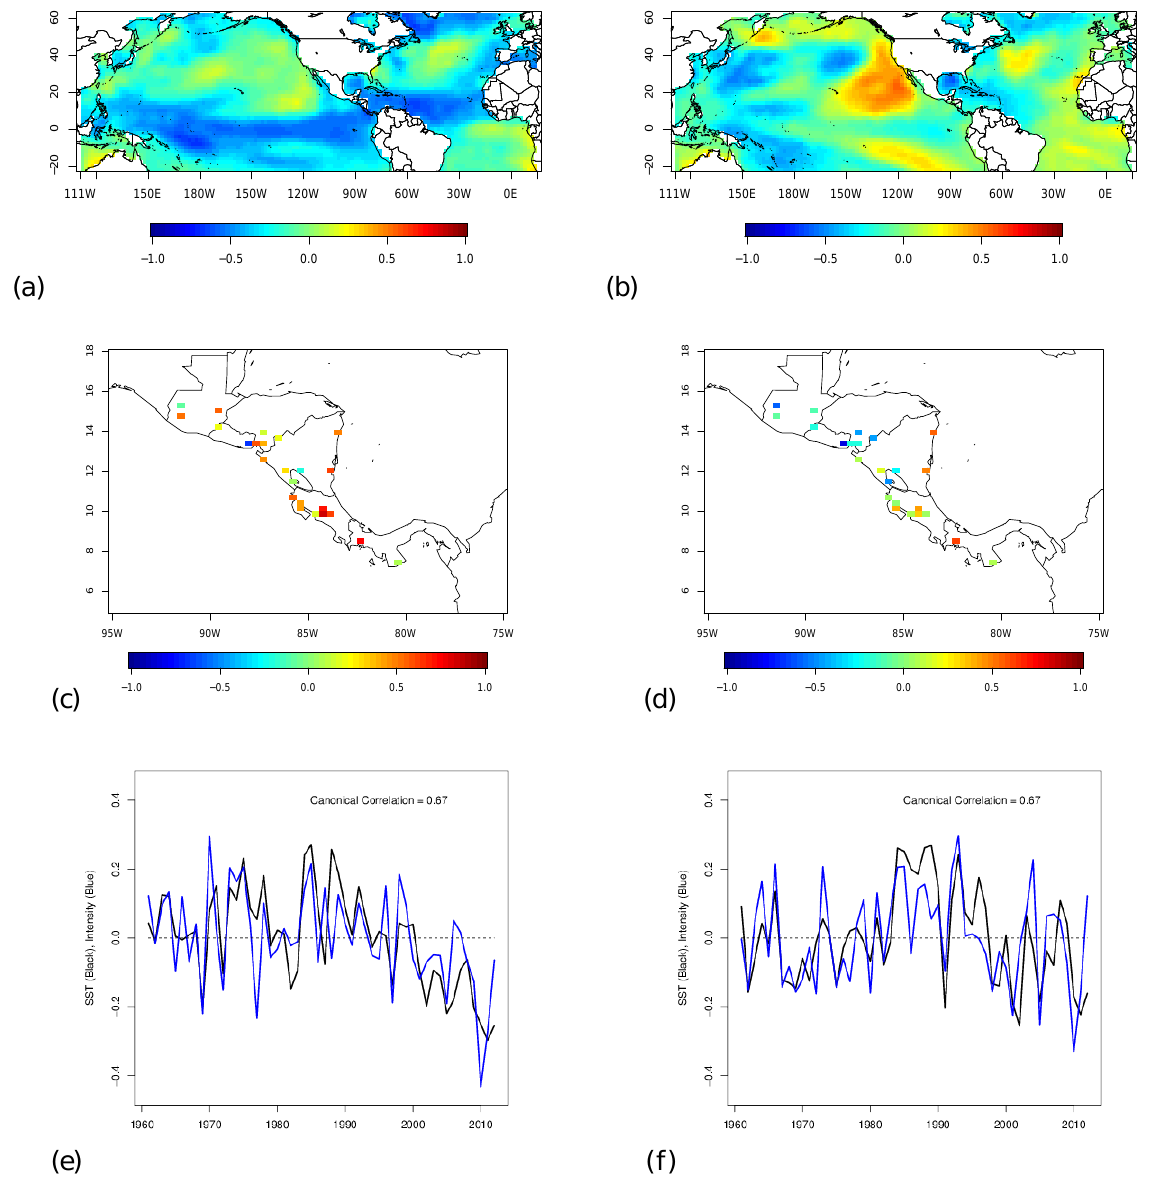
Figure 10. Same as Fig. 9 but for Mode